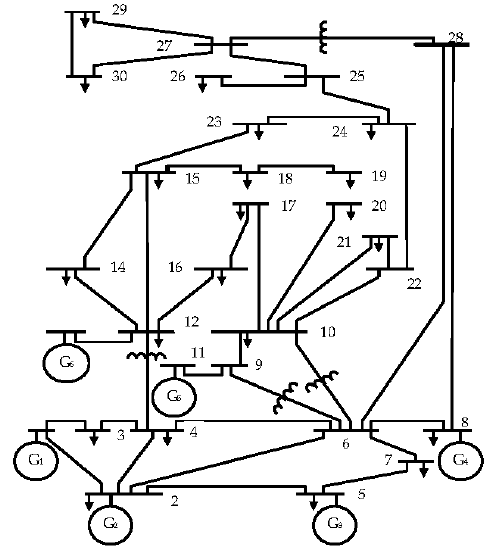
Figure 5. IEEE 30-bus system. Table 1. Output Control Variables Obtained After Optimization For IEEE 30 Bus. Control Variable Settings